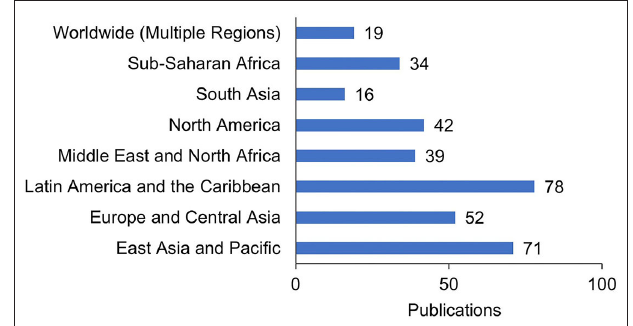
FIGURE 4 | Distribution of publications by the region where they were developed. Those based on reviews covering more than one region were considered under the category